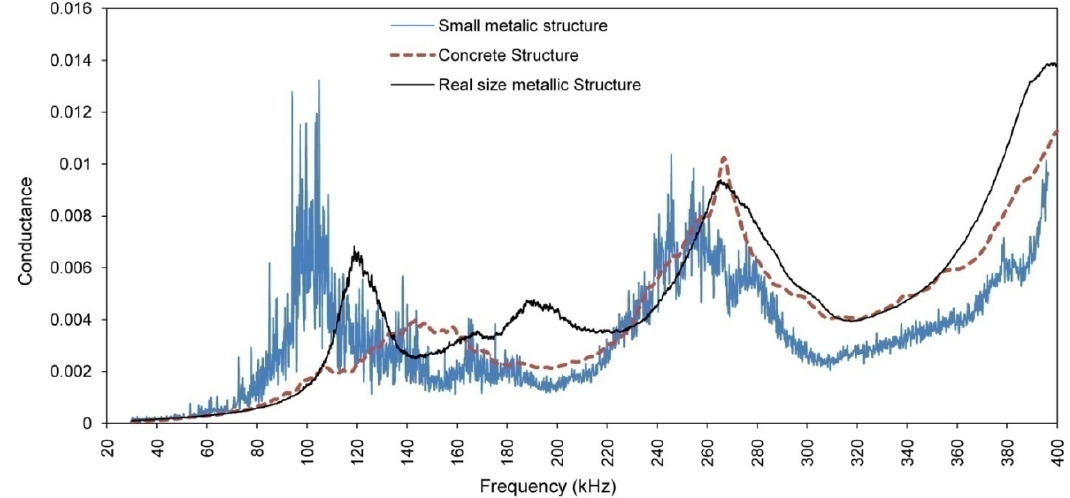
Figure 7. Typical EMI signature for small metallic structures, concrete structure and real size metallic